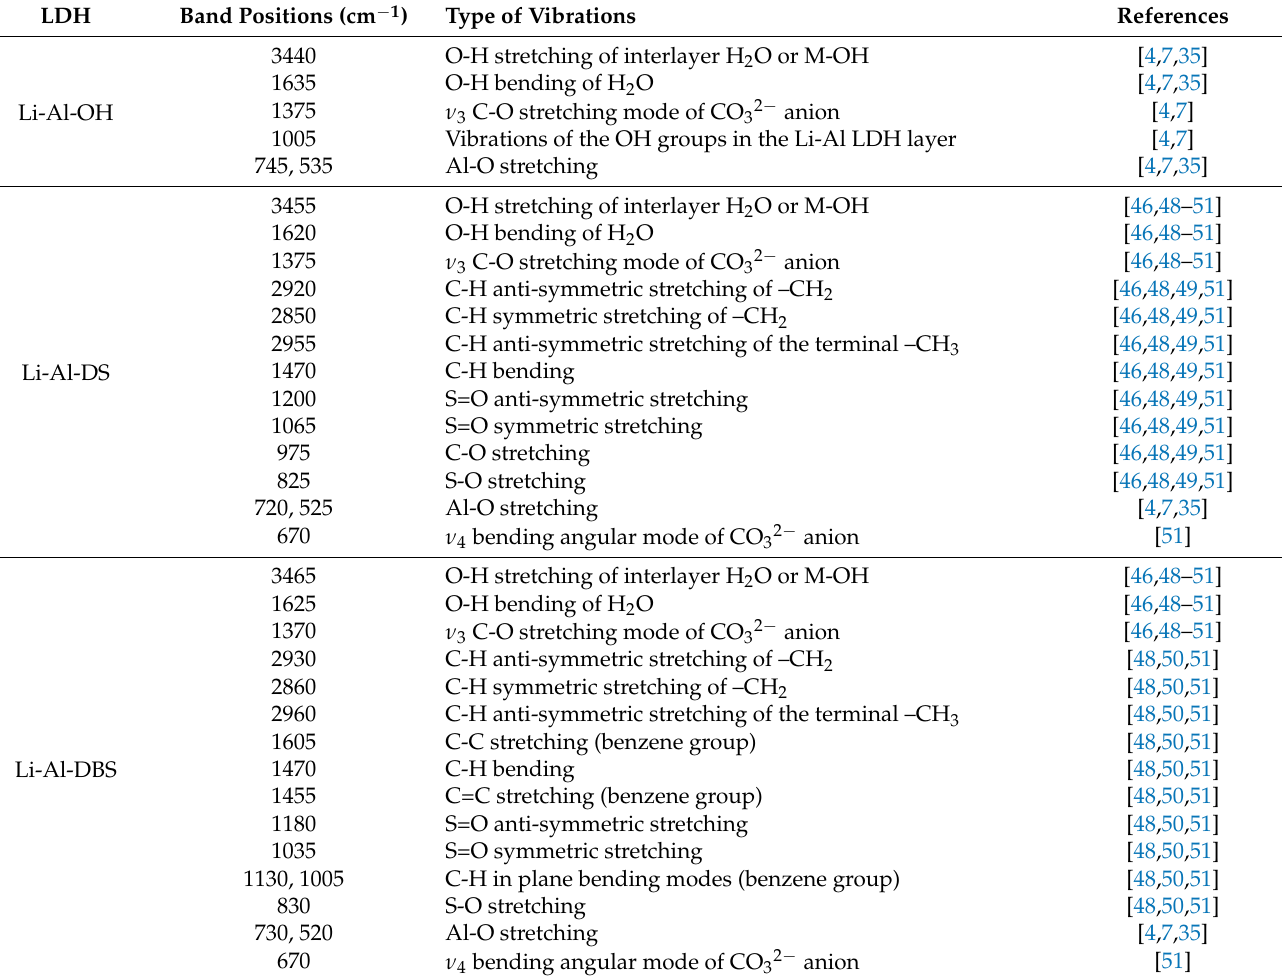
shifts to lower wavenumbers than SDS [46,48,49,51]. A downward shift in wavenumber corresponds to a weakening of the S=O bond strength, suggesting the presence of a hy- drogen bond between the LDH layer and sulfate groups (S=O . . . H-O-Al) in addition to electrostatic attraction and van der Waals forces between LDH layers and surfactant molecules [50,51]. The bands at 975 and 825 cm − 1 represent the stretching vibration modes of C-O and S-O, respectively. The bands at 720 and 525 cm − 1 are due to the Al-O stretching mode. The ν 4 bending angular mode of CO 32 − anions manifested at 670 cm − 1 [51]. Table 2. Assignment of FTIR bands in Li-Al-OH ([LiAl 2 (OH) 6 ]OH · 2H 2 O), Li-Al-DS, and Li-Al-DBS LDHs.